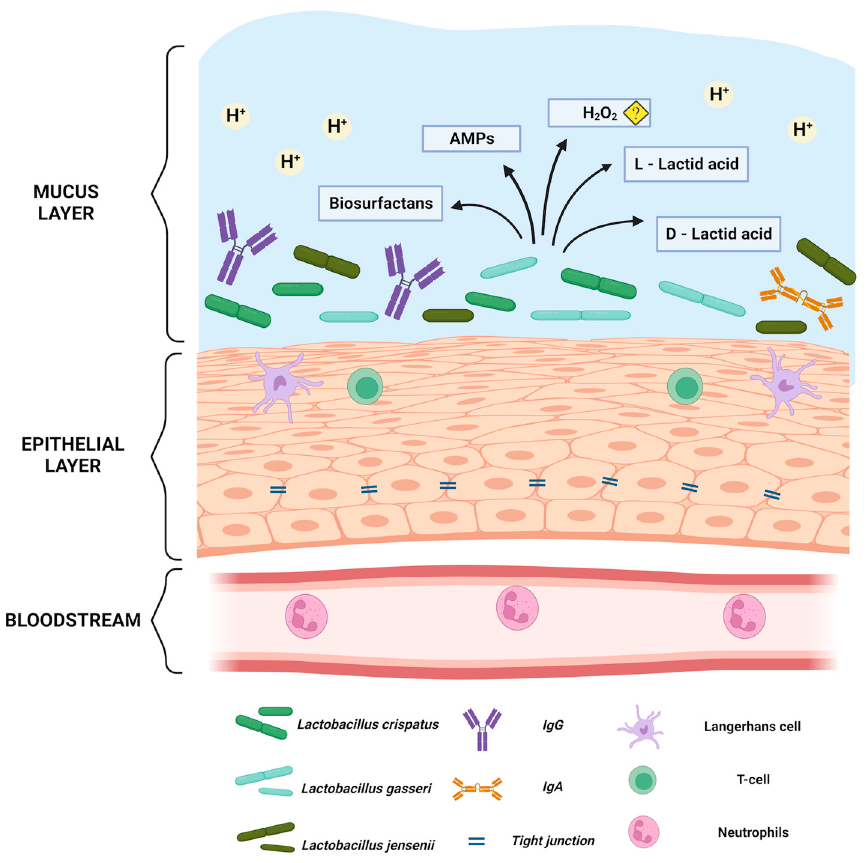
Figure 1. The normal Lactobacillus spp. dominant vaginal mucosa. Created with BioRender.com. Figure 1 legend: Illustration showing below the bloodstream under the basal mem- brane, from where neutrophils can be attracted if pathogens enter the vagina. The vaginal